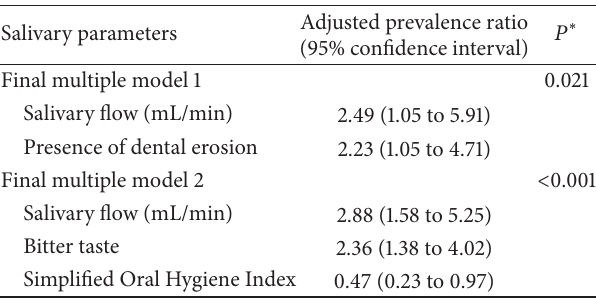
Table 4: Multiple Poisson regression analysis between independent variables and presence of dental